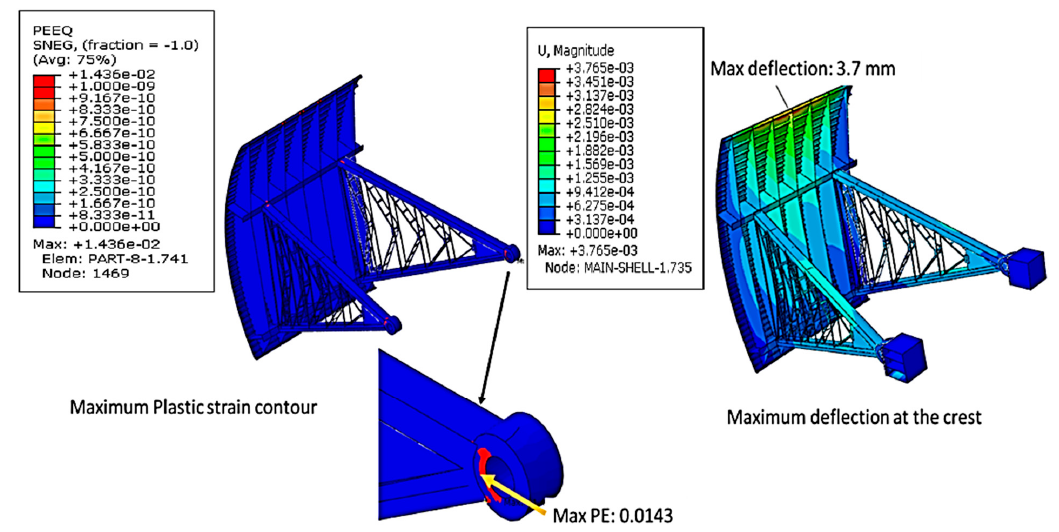
Figure 11. Strain and displacement distribution as a result of a shock wave (MCL earthquake).